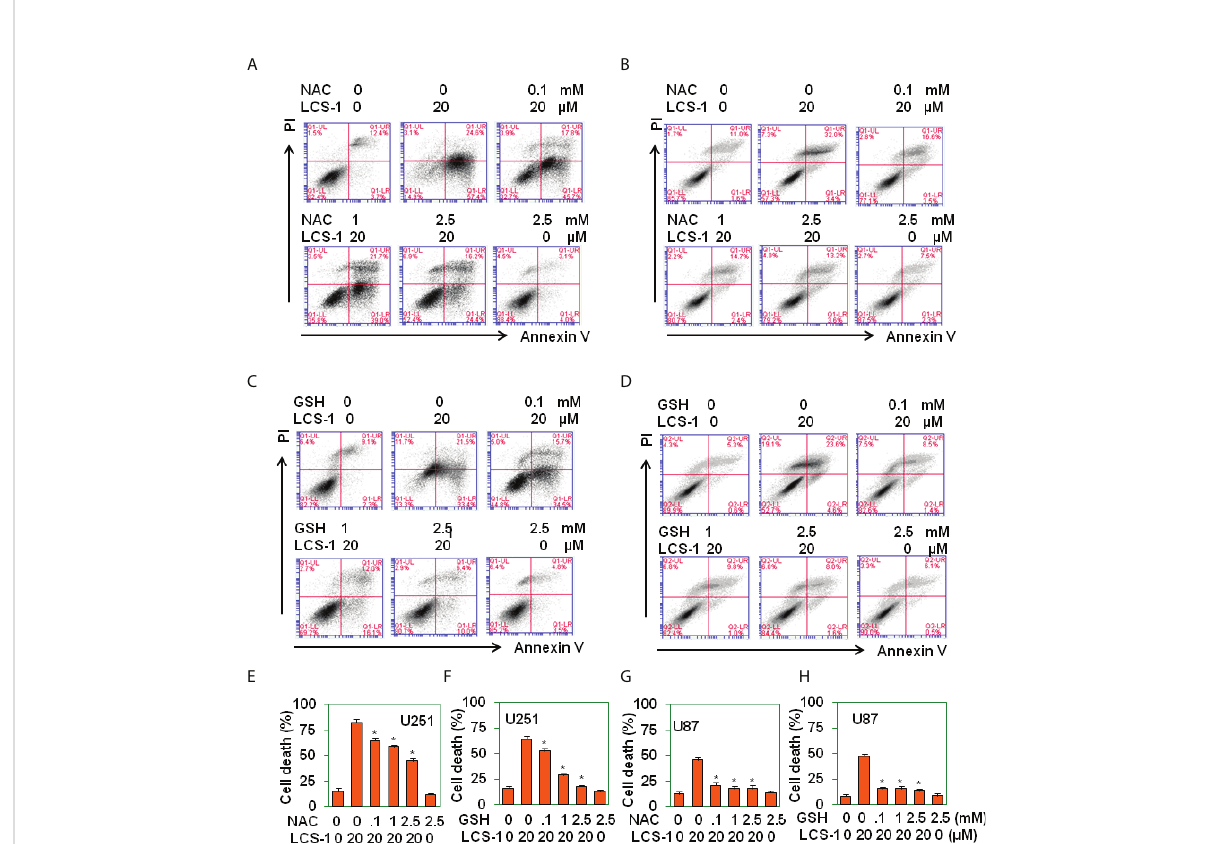
FIGURE 5 ROS scavenges reverse LCS-1-induces cell death. (A-D) PI/FITC-Annexin V staining of death of U251glioma cells pretreated with the indicated doses of NAC (A) , or GSH (B) for 1 h and re-treated with 20 µM LCS-1 for 24 h, and U87 cells pretreated with indicated doses of NAC (C) , or GSH (D) for 1h and retreated with 20 µM LCS-1 for 24 h (E-H) Quantitative data from A (E), B (F), C (G) and D (H) respectively. * P < 0.05 compared with LCS-1-treated alone